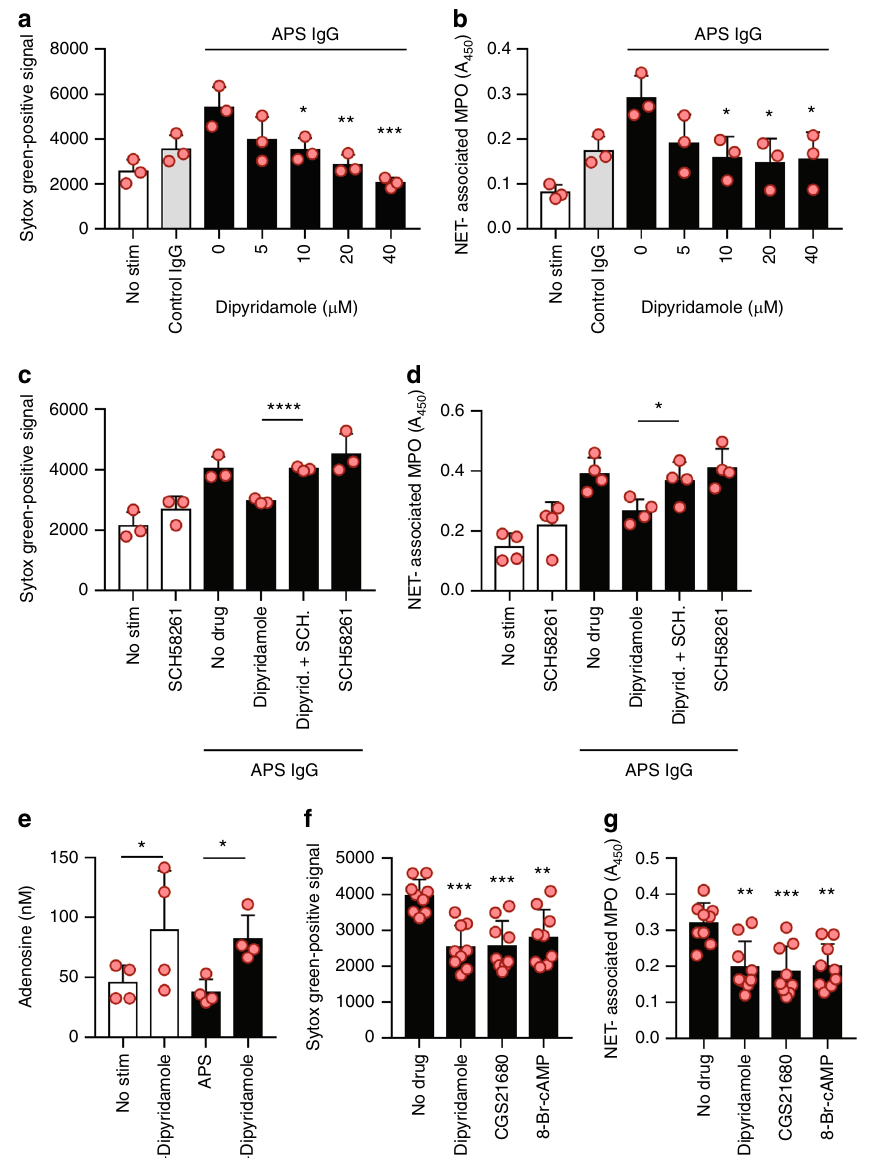
Fig. 4 Dipyridamole suppresses NETosis via activation of the adenosine A 2A receptor. a , b Neutrophils were isolated from healthy volunteers and then treated with either control IgG or APS IgG for 3 h. Some samples were additionally treated with dipyridamole as indicated. In panel a , total extracellular DNA was measured as relative fl uorescence units upon the addition of Sytox Green. In panel b , an independent set of experiments was performed, with NETosis quanti fi ed by measuring the enzymatic activity of nuclease-liberated myeloperoxidase (MPO). Mean and standard deviation are presented for n = 3 independent experiments; * p < 0.05, ** p < 0.01, and *** p < 0.001 as compared with the 0 µ M group by one-way ANOVA corrected with Dunnett ’ s test. c , d Neutrophils were treated with APS IgG in the presence of different combinations of dipyridamole and the A 2A receptor antagonist SCH58261. Extracellular DNA ( c ) or NETs ( d ) were quanti fi ed as above. Mean and standard deviation are presented for n = 3 independent experiments; * p < 0.05 and ** p < 0.01 by one-way ANOVA. e Neutrophils were treated with APS IgG (black bars) and dipyridamole as indicated. Adenosine was quanti fi ed in culture supernatants. Mean and standard deviation are presented for n = 4 independent experiments; * p < 0.05 by one-way ANOVA corrected with Sidak ’ s test. f , g Neutrophils were isolated from patients with primary APS and immediately placed in culture. Some samples were additionally treated with drugs as indicated. Extracellular DNA ( f ) or NETs ( g ) were quanti fi ed as above. Mean and standard deviation are presented for n = 9 patients; ** p < 0.01 and *** p < 0.001 as compared with the no-drug group by one-way ANOVA corrected with Dunnett ’ s